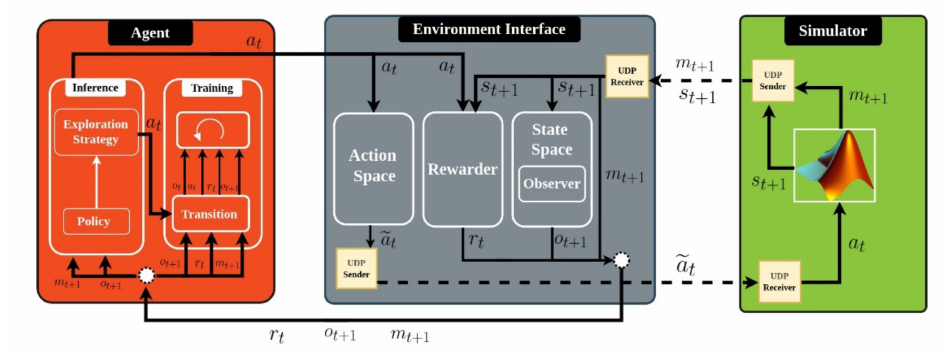
Figure 2. Integrated modular software framework based on Reinforcement Learning for hybrid electric